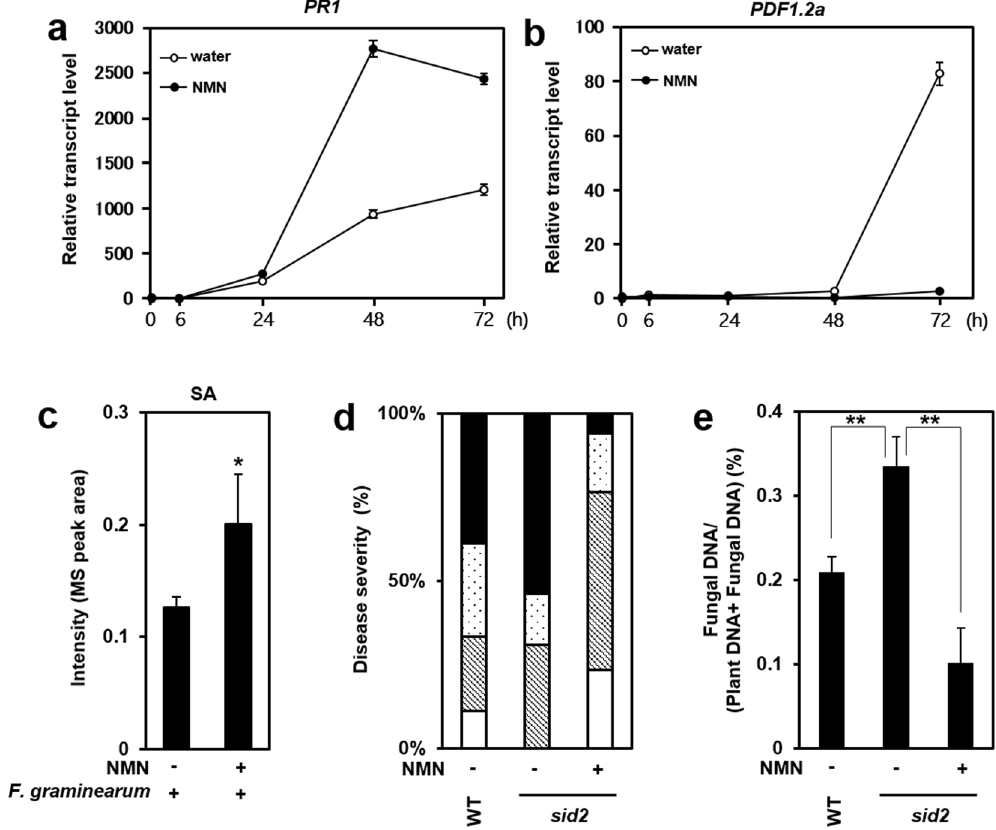
Figure 2. Involvement of the SA signalling pathway in F. graminearum -infiltrated Arabidopsis leaves with and without NMN pretreatment. ( a,b ) RT-qPCR analysis of PR1 and PDF1.2a mRNA expression in F. graminearum - inoculated WT plants with and without NMN pretreatment. Six hours after NMN pretreatment (time point 0), leaves were injected with F. graminearum (n = 18). Plants were incubated under high humidity conditions and harvested at 0, 6, 24, 48 and 72 h. ACTIN2/8 ( Act2/8 ) was used as the reference gene. The data represent the average of all samples, and error bars represent the standard deviation (n = 3). ACTIN2/8 ( Act2/8 ) was used as the reference gene. Each value is shown as fold change (each sample vs 0 h of water treatment). Error bars represent the standard deviation (n = 3). ( c ) Accumulation of salicylic acid (SA). (Student’s t-test * P < 0.05) ( d,e ) NMN induces disease resistance against F. graminearum via the salicylic acid (SA)-independent signalling pathway. NMN (0.3 mM) was sprayed onto the surface of sid2-2 rosette leaves prior to incubation for 6 h. Six hours after NMN treatment, conidia solutions (1 × 10 5 conidia/ml) of F. graminearum were injected into leaves. ( d ) The disease severity was evaluated by the disease symptoms of inoculated leaves 3 days after inoculation (n = 18). Open box: normal, cross-hatched box: colour change, dot box: partial aerial mycelium, closed box: expanded aerial mycelium. ( e ) F. graminearum DNA was measured by qPCR. Error bars represent the standard deviation (n = 3) (Student’s t-test ** P <